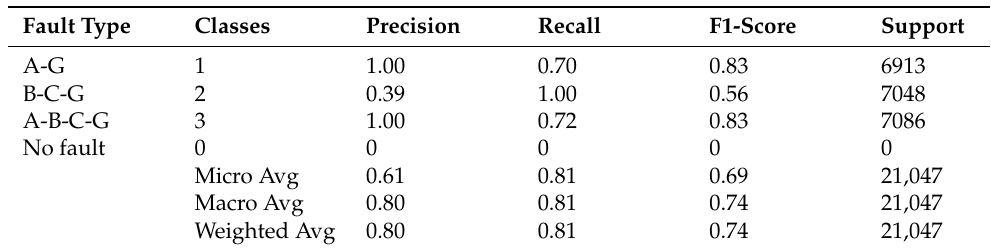
Table 6. Fault classification